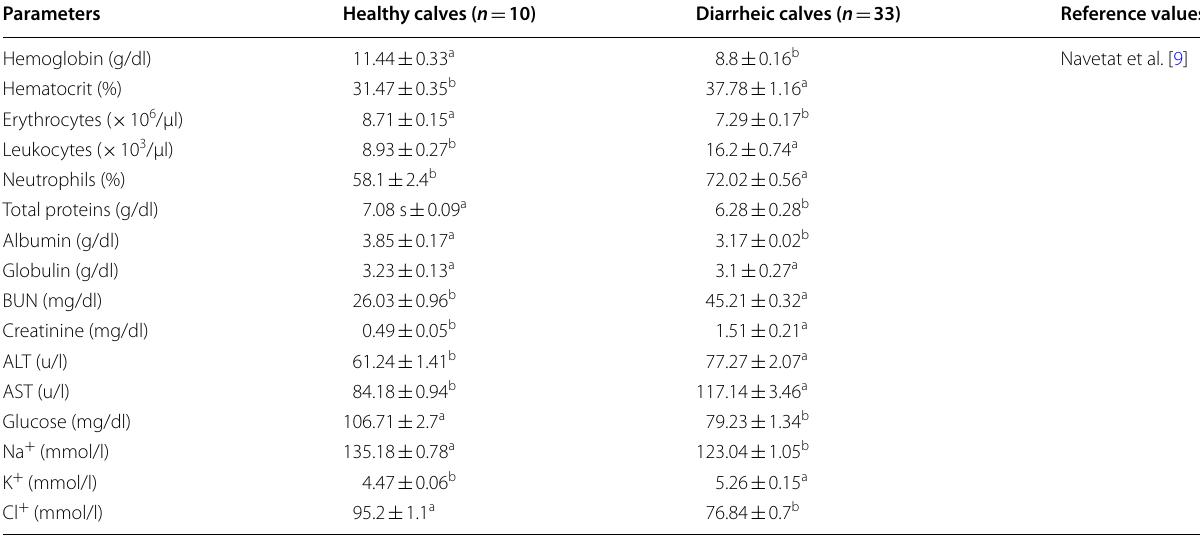
The data are presented as mean a,b Means within the same row with different superscripts differ significantly ( P < 0.05)